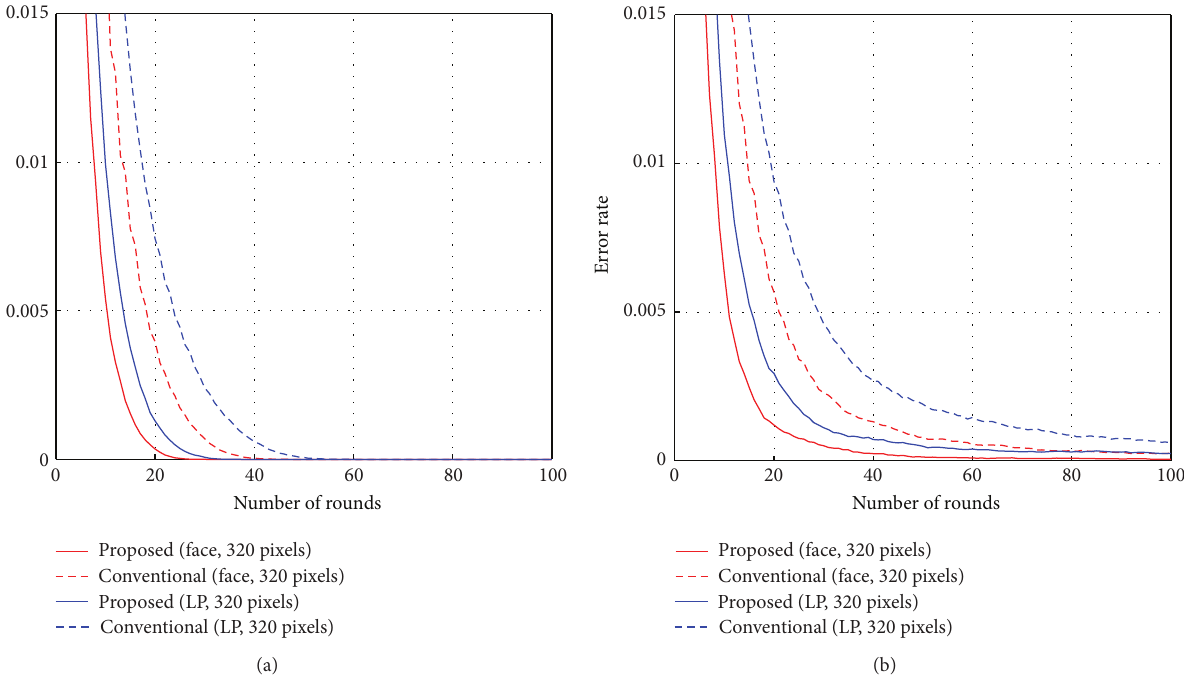
Figure 9: (a) Comparison of learning methods for training error. (b) Comparison of learning methods for testing